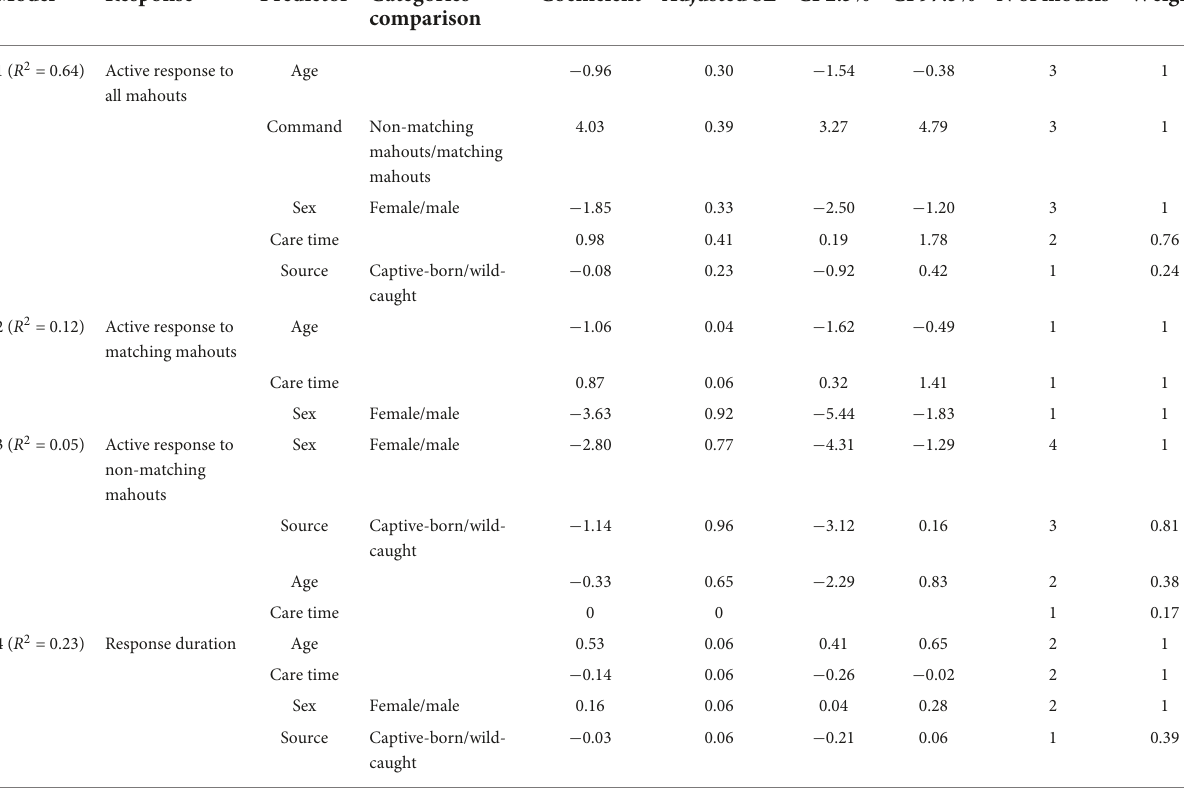
TABLE 2 The full-averaged results from the information-theoretic approach-based model selection. Model